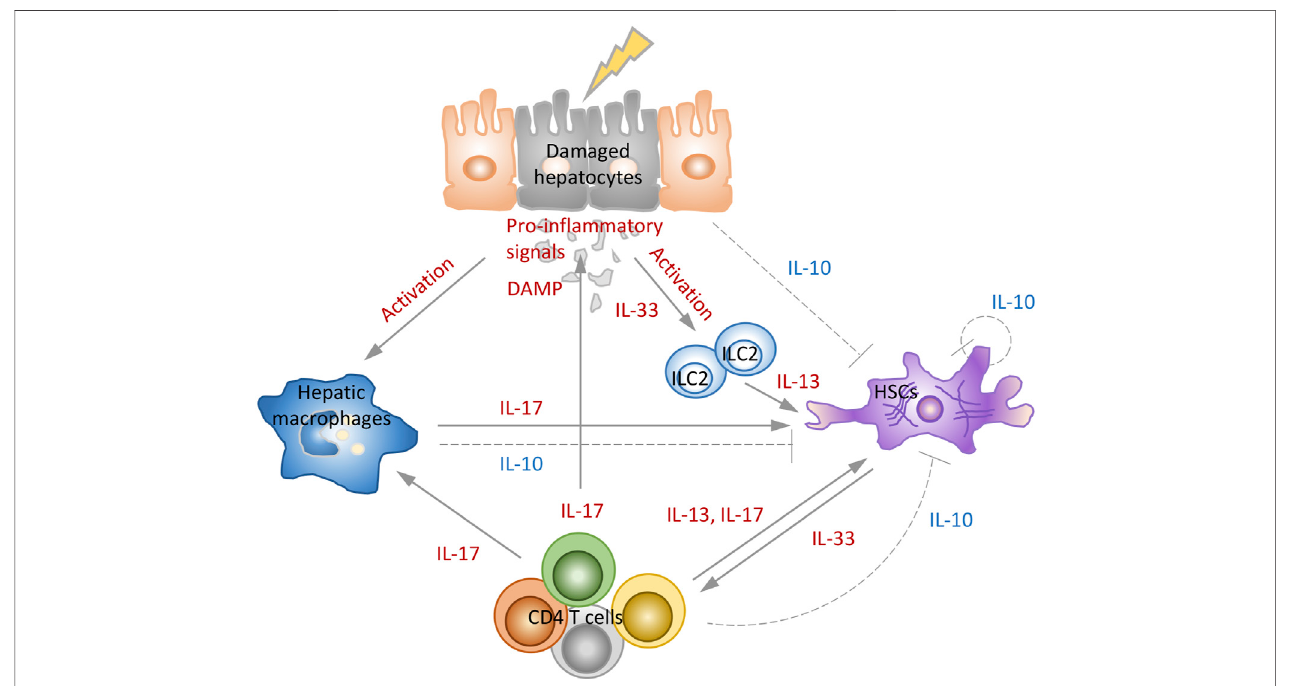
FIGURE 2 | Role of interleukins in development and resolution of liver fi brosis. The combination of signals from in fl ammatory environment, hepatocytes death, activatedmacrophagesandCD4TcellsstimulatesHSCstoproliferateandsynthesizecollagenandinduce fi brosis.IL-33inducestheproductionofIL-13,andIL-13and IL-17directlymediatetheactivationofHSCs.Inthemodelof fi brosisresolution,hepatocytes,macrophages,HSCs,andCD4Tcellsactivatethenegativefeedbackloops that reduce immune-mediated fi brosis by secreting IL-10 that prevent activation of HSCs and production of collagen.